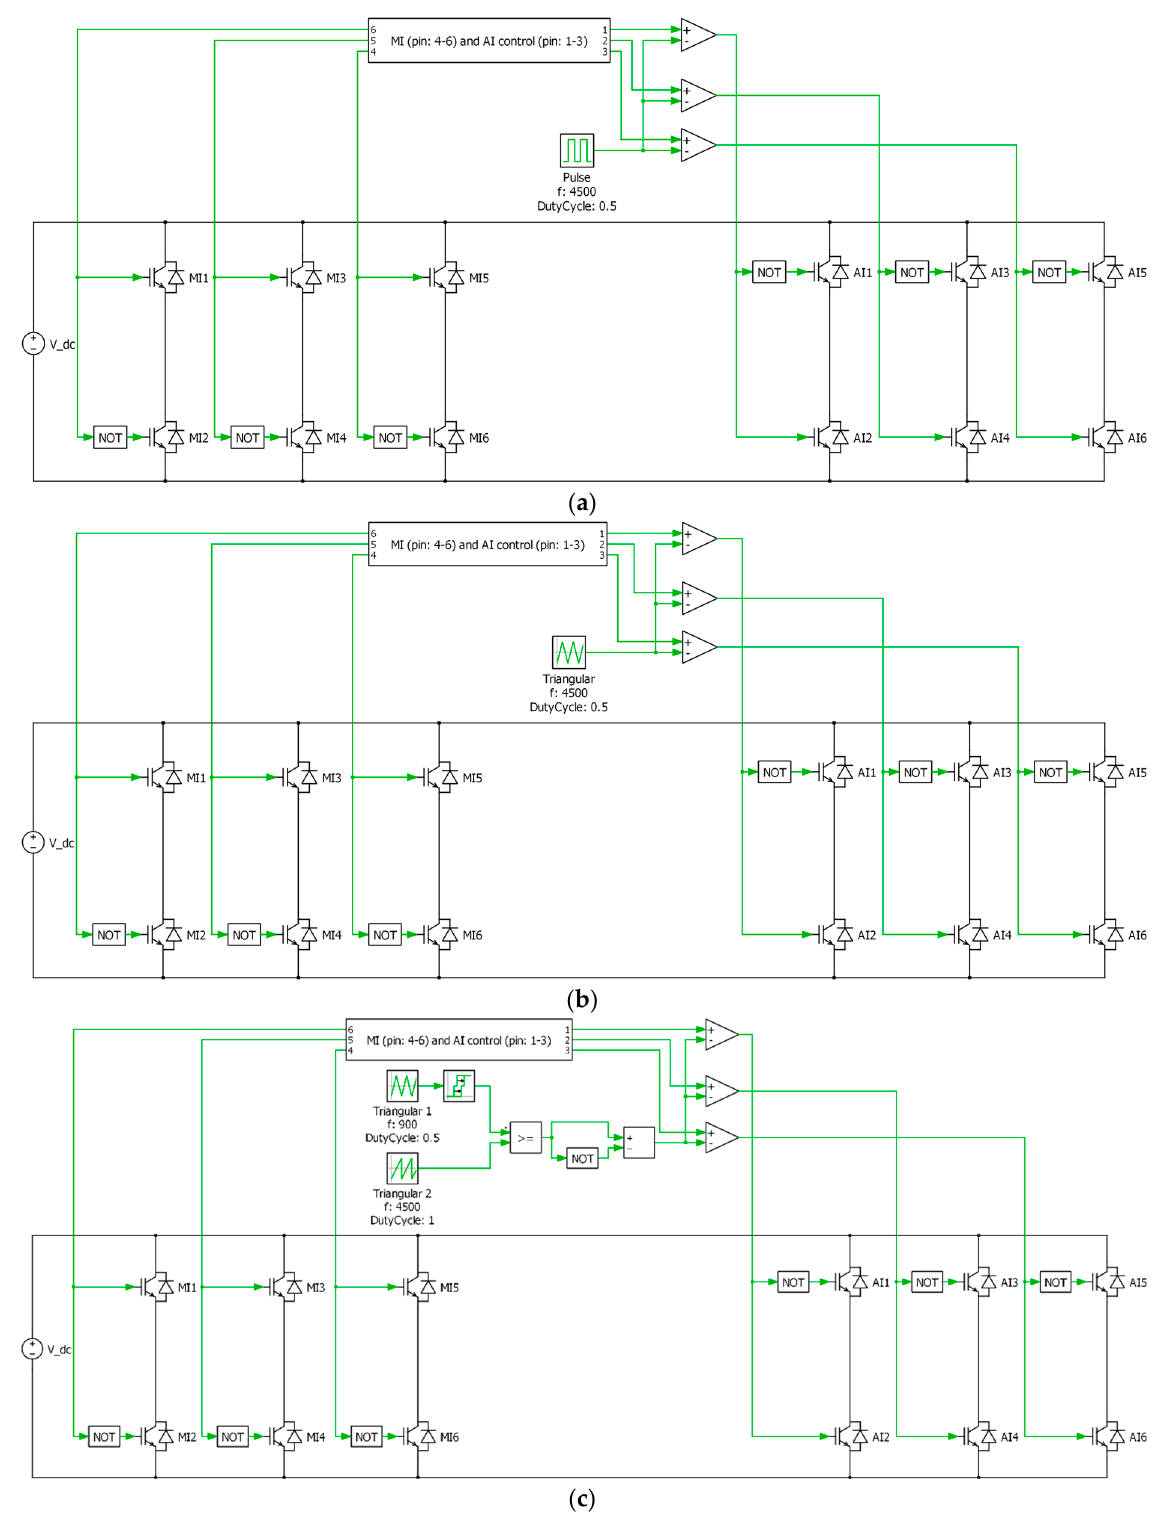
Figure 12. OVT inverter models including the implementation of modified control systems for the auxiliary inverter for the variant when a pulse generator ( a ), triangular generator ( b ), and PWM generator ( c ) are